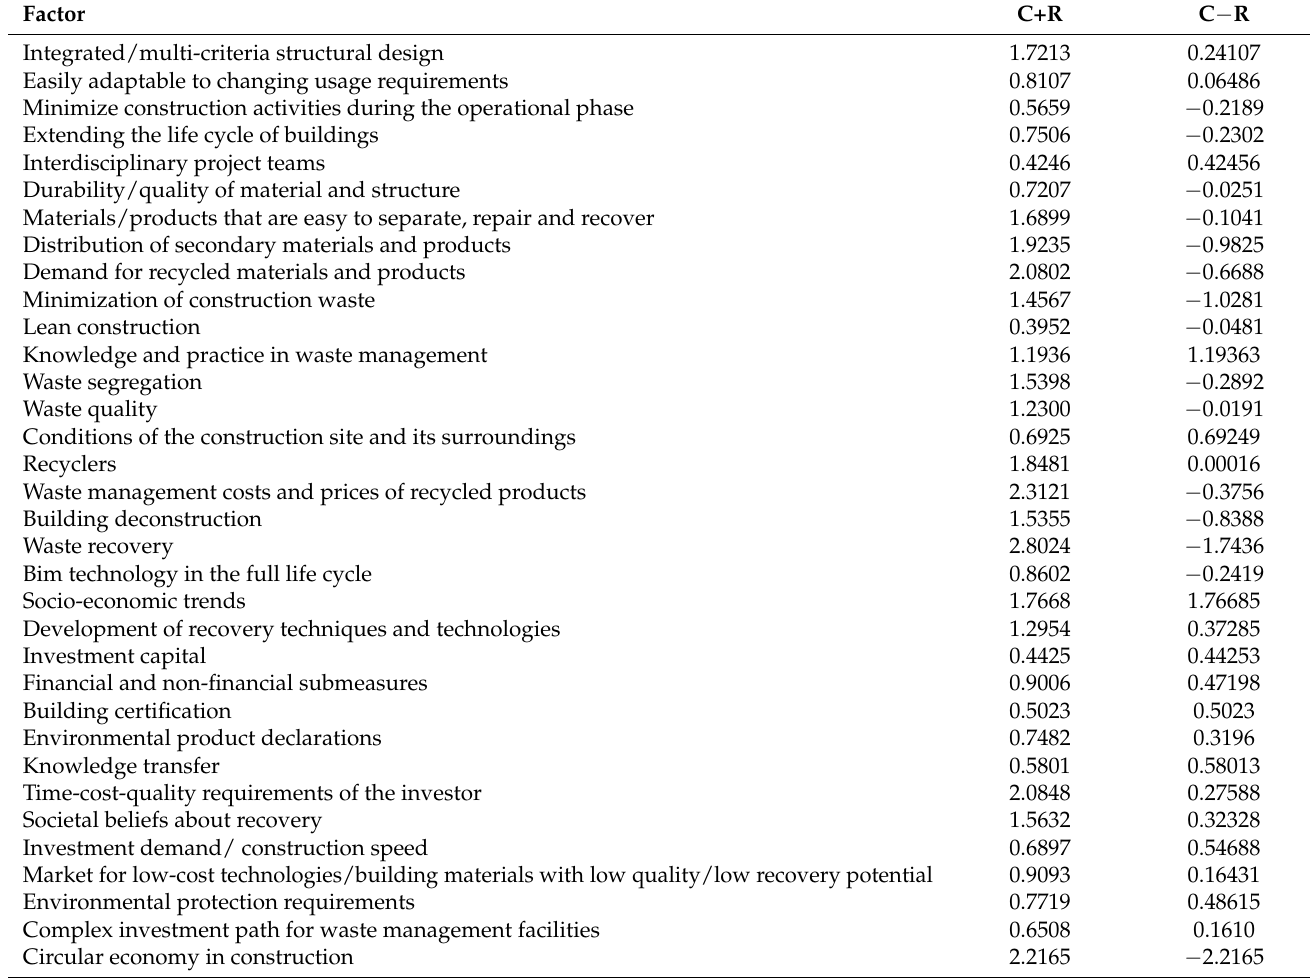
Table A2. “Prominence” (R+C), and the “relation” (C −